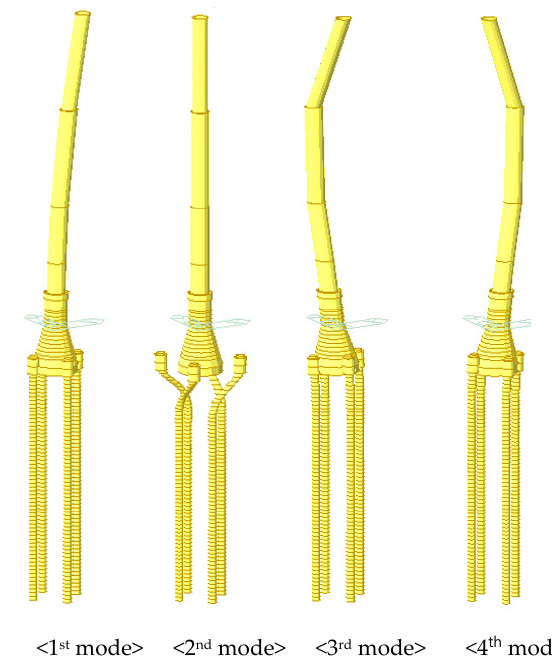
Figure 16. Mode shapes of PCF. Table 9. Results of natural frequency analysis.